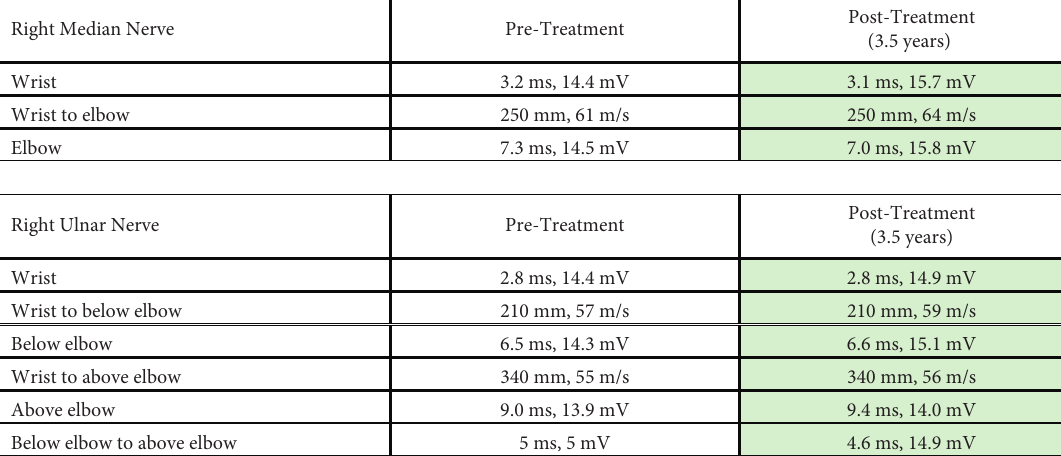
Table 3: Nerve conduction findings of right